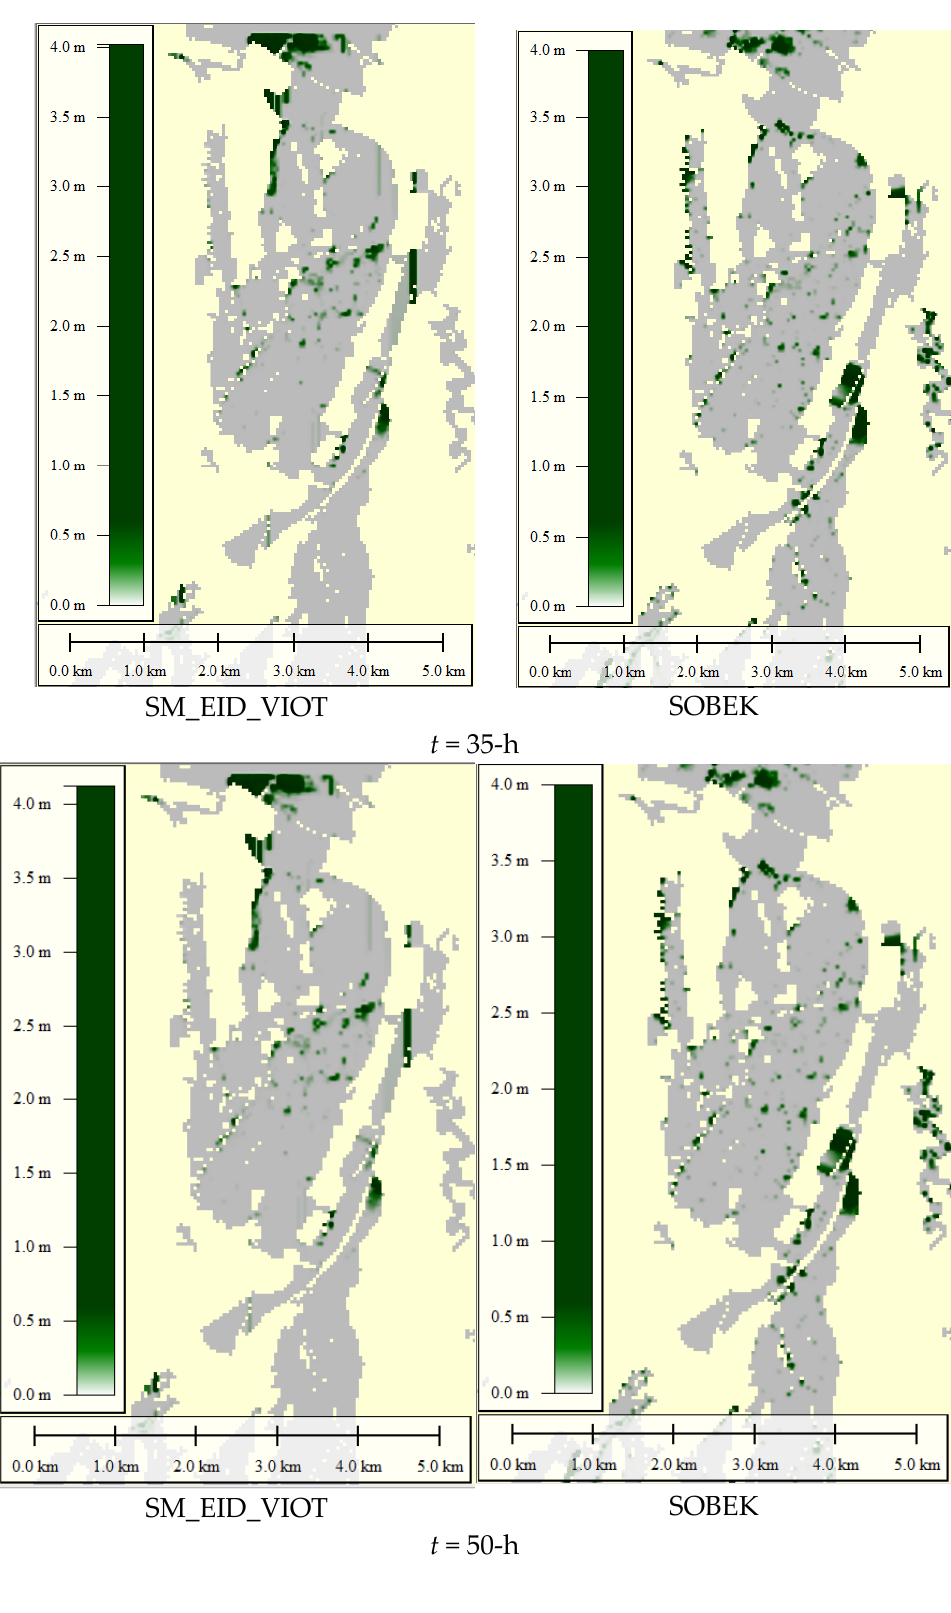
Figure 21. Comparison of the estimated flooding regions via the proposed SM_EID_VIOT model with results from the SOBEK model at the specific time steps.